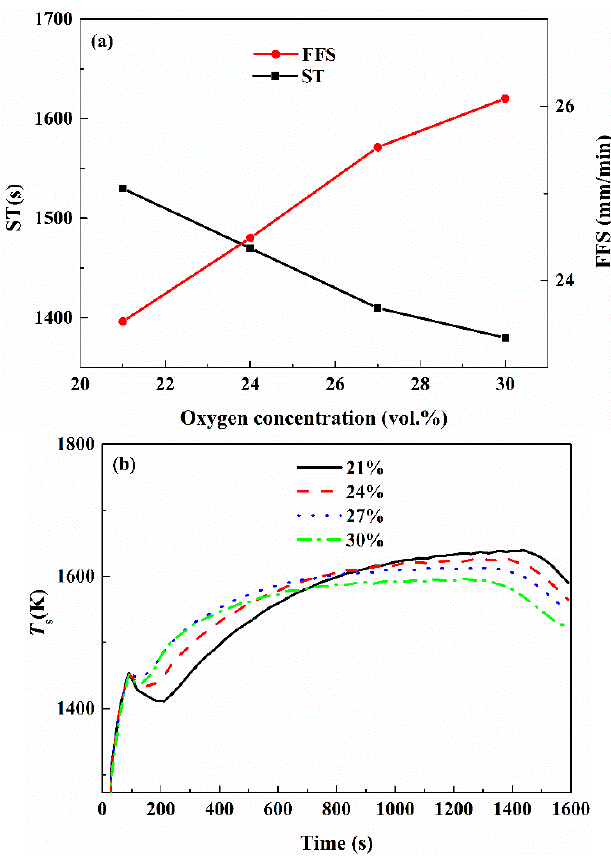
Figure 11. FFS and ST ( a ) and MaxT ( b ) with different oxygen concentrations.